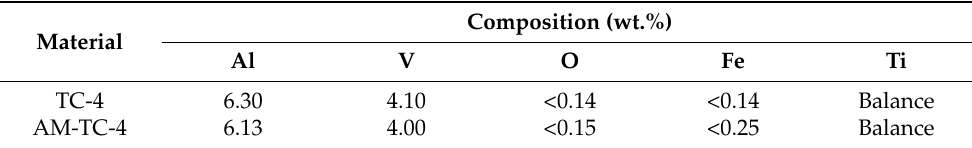
Table 1. Chemical compositions of TC-4 and